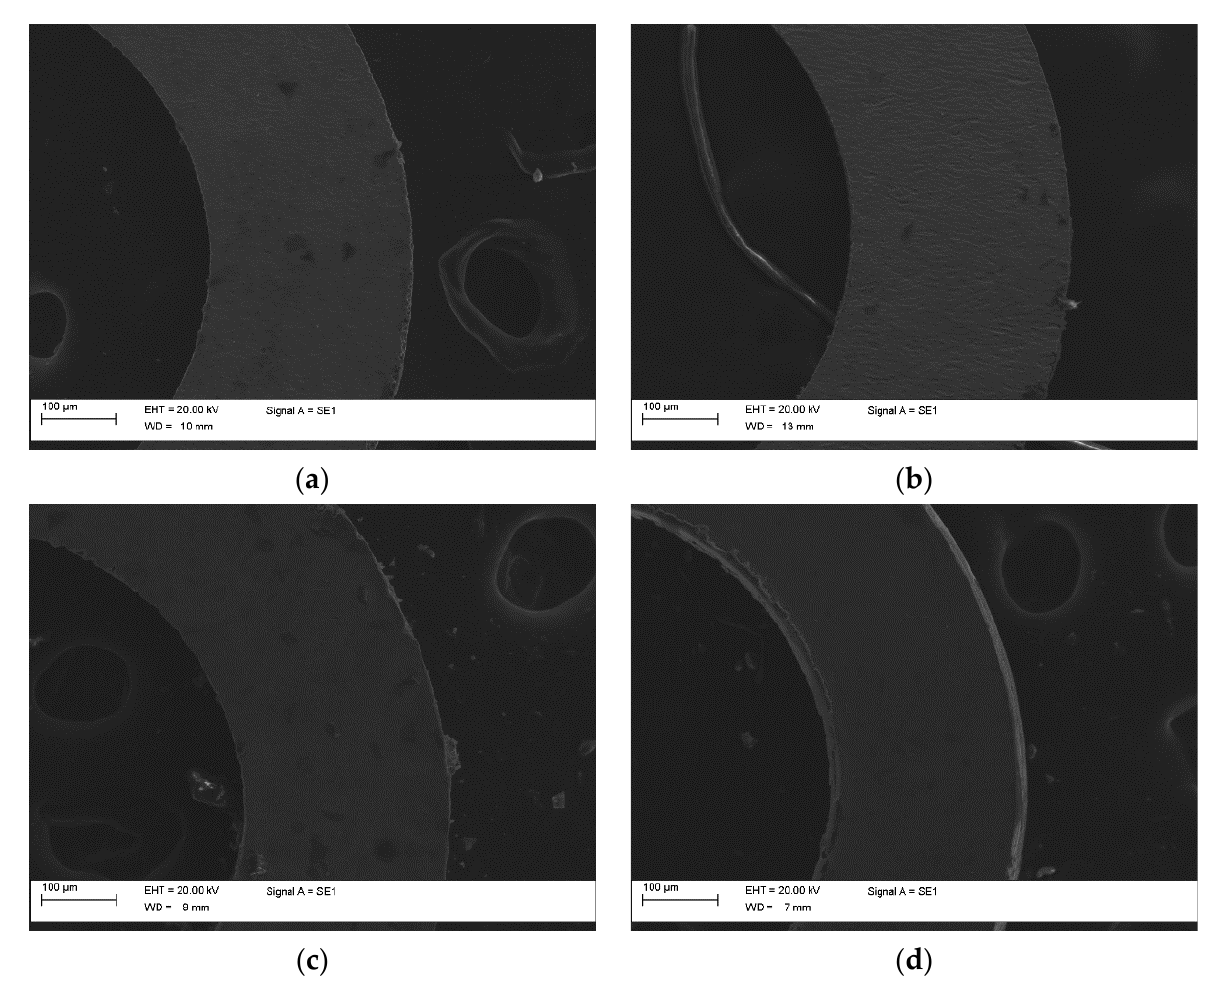
Figure 6. Representative image of a diamond-like element, laser-cut from the straight-annealed NiTi sheets.